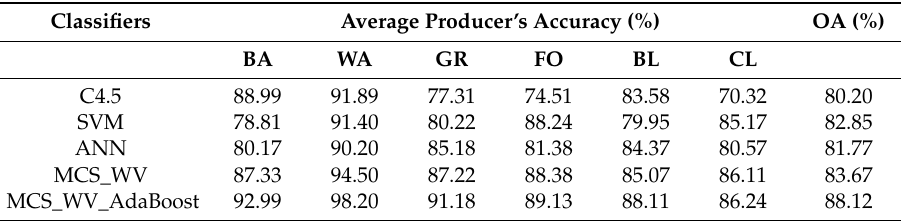
Table 4. Classification average producer’s accuracy with different classification